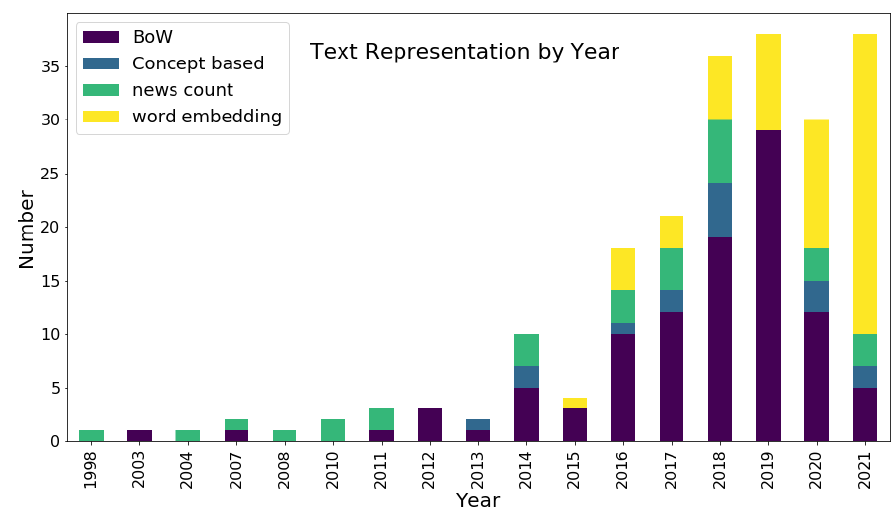
Figure 2. Distribution of reviewed works based on the text representation methods. Table 1. Information sources in terms of